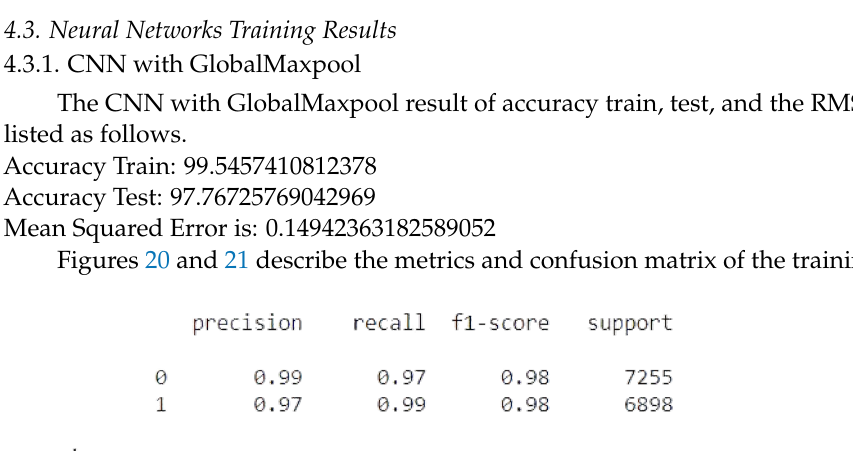
Figure 19. Random Forest confusion matrix.